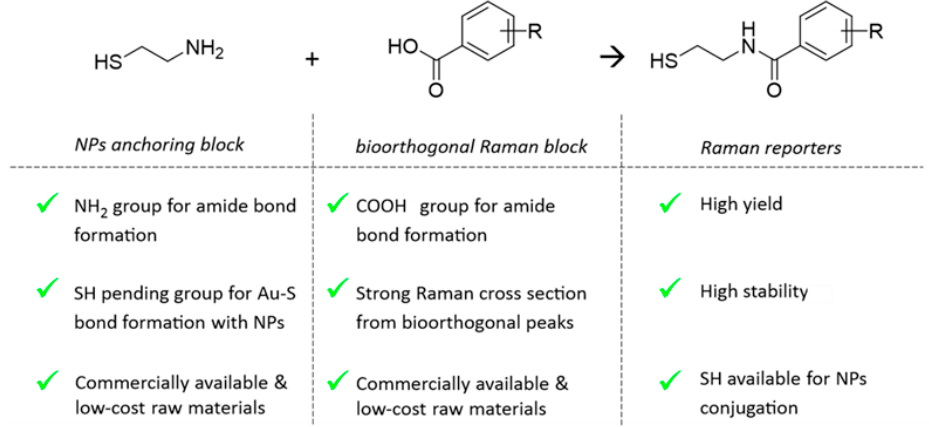
Figure 1. Scheme reporting the key chemical moieties and related advantages for the two compounds constituting the building blocks selected to engineer novel bioorthogonal RRs conjugable to gold